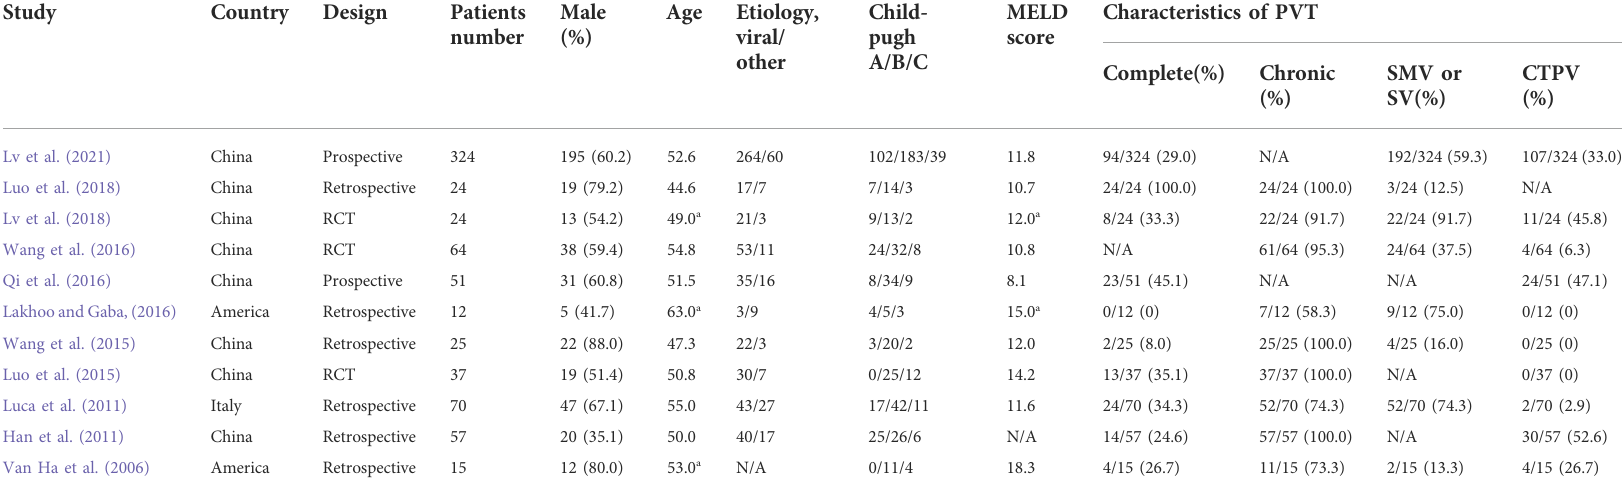
TABLE 1 Characteristics of the included studies and patient populations.